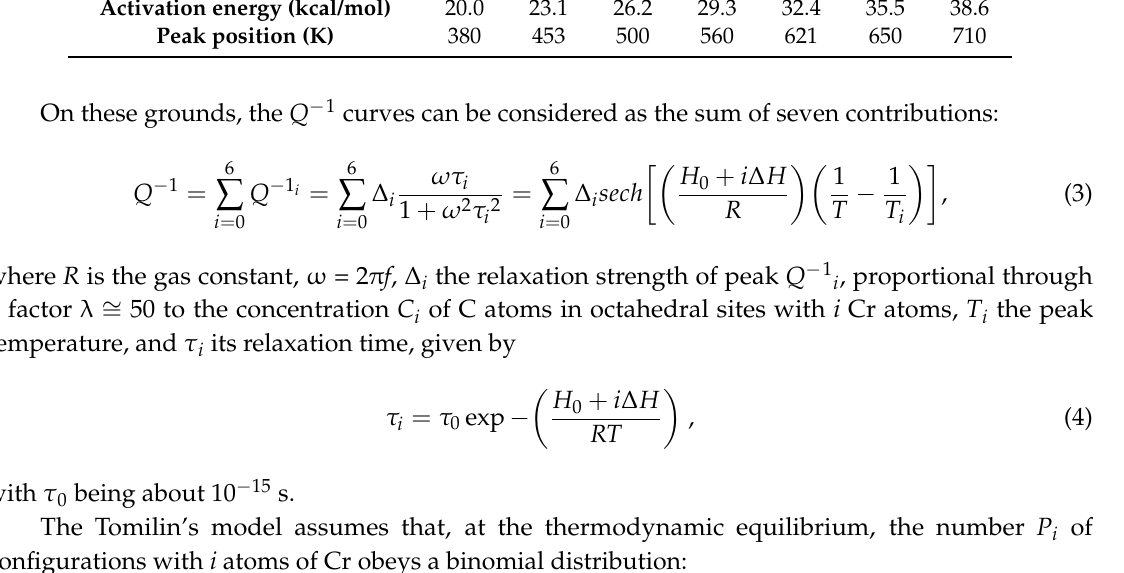
Table 2. Activation energies and peak positions of the seven Q − 1 i peaks corresponding to octahedral configurations with a number of Cr atoms i varying from zero to six. (Resonance frequency f = 250 Hz.) Number of Cr Atoms i 0 1 2 3 4 Activation energy (kcal/mol) 20.0